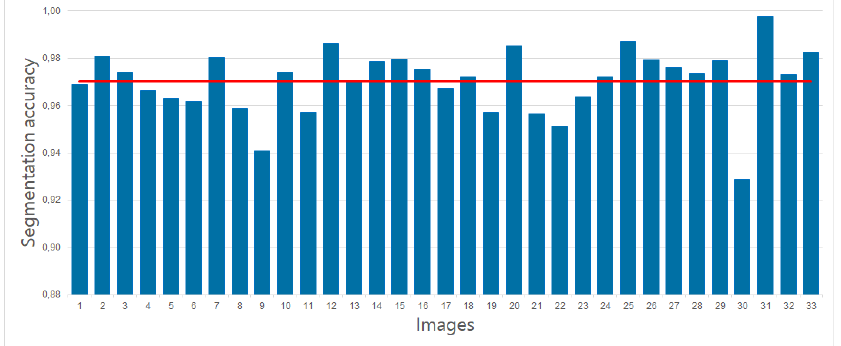
Figure 11. Pixel-wise segmentation accuracy for every tested image. The red line indicates an average accuracy of 97.02% on the first 33 images.